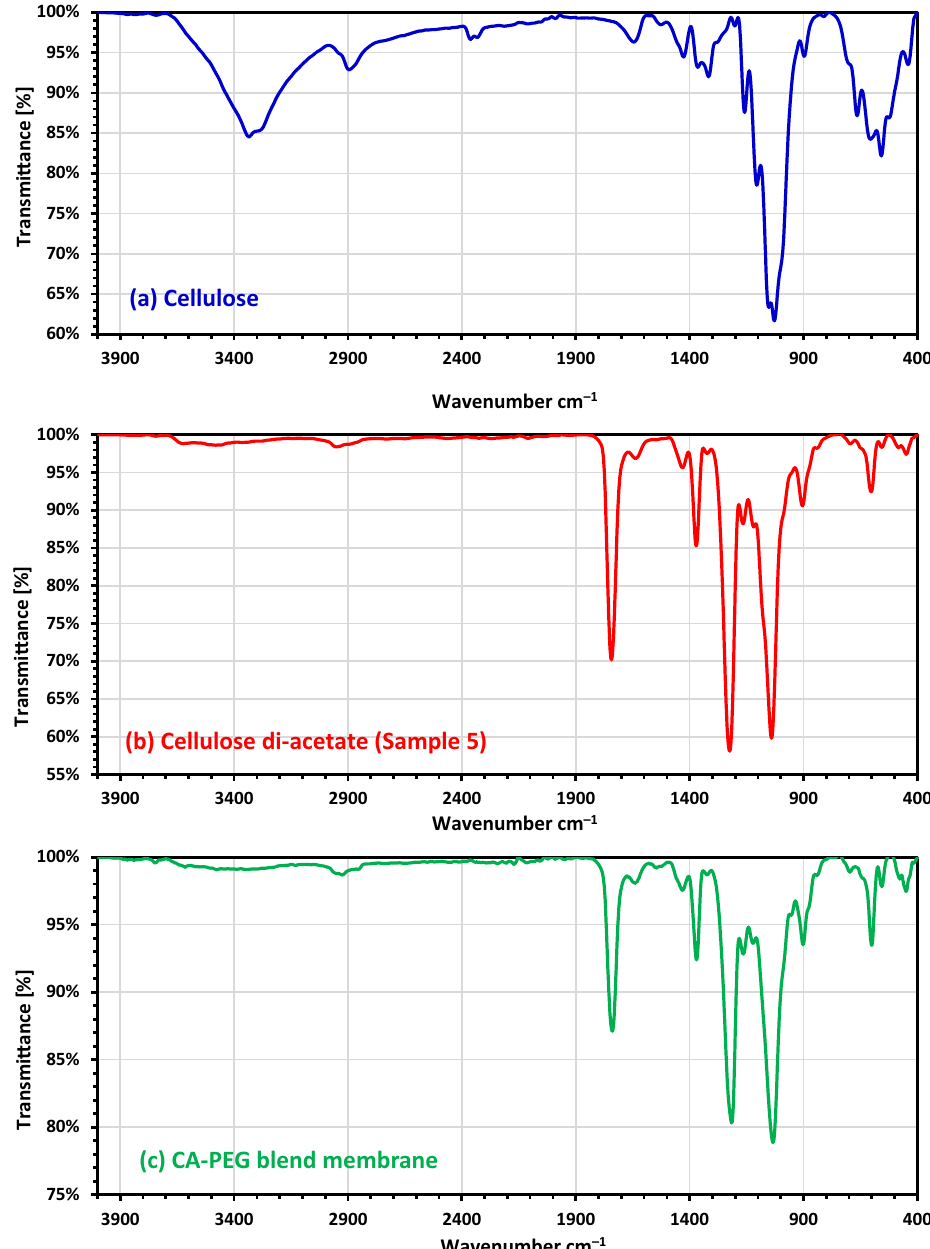
Figure 3. FTIR analysis of ( a ) Cellulose extracted from cotton Giza 86, ( b ) Cellulose di-acetate (Sample-5), ( c ) CA-PEG blend membrane prepared from Sample